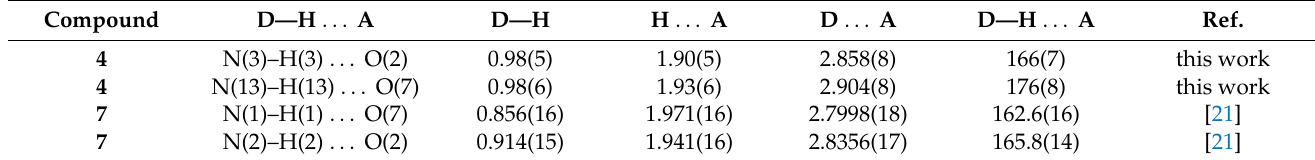
Figure 4. Hydrogen bonding pattern for compound 4 viewed along the b axis. Table 3. Hydrogen bonding parameters for 4 and comparison compound 7 (Å , °).